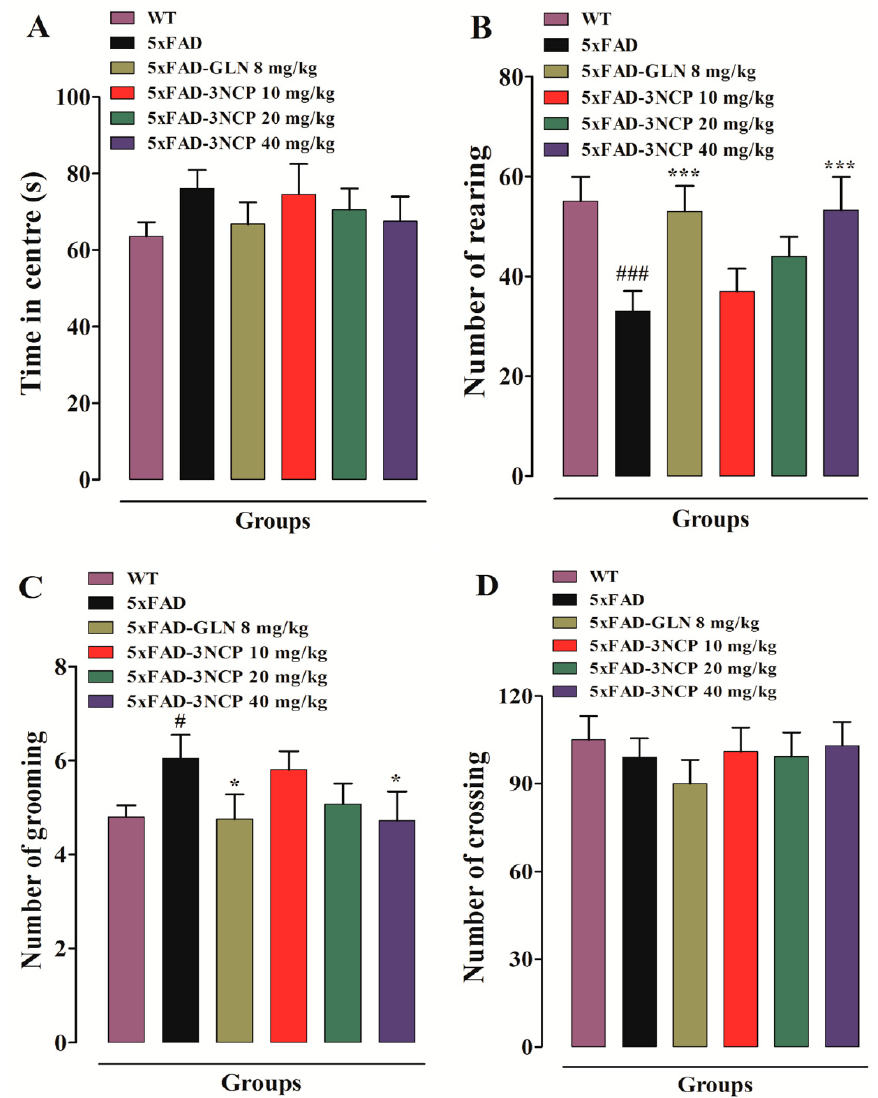
Figure 2. ( A ) Time in center; ( B ) number of rearing events; ( C ) number of grooming and ( D ) number of square crossing in the open field test after treatment with 3NCP / vehicle / galanthamine. Bars represent mean ± SEM. * p < 0.05, *** p < 0.001 compared to 5xFAD mice, # p < 0.05 and ### p < 0.001 compared to non-transgenic WT-mice. Data was analyzed with one-way ANOVA followed by Dunnett post hoc test ( n = 10 mice/group).